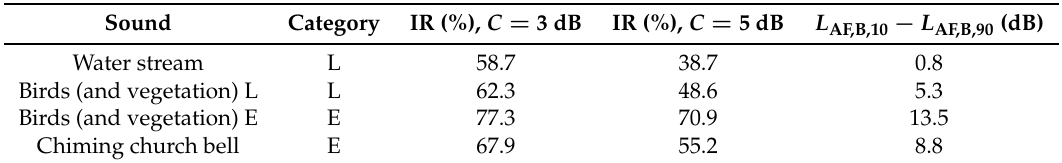
Table 1. Information about the background sounds at the exemplary L Aeq,B of 41 dB(A). For the calculation of intermittency ratio (IR), C is the dB-offset (i.e., the dB difference to L Aeq,B ) beyond which events were counted [31].